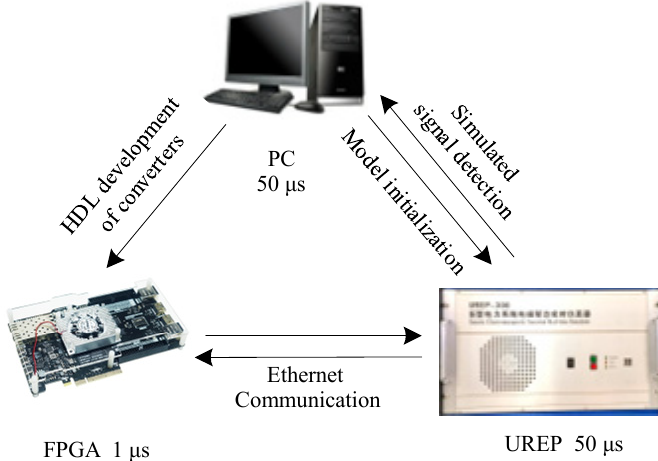
Figure 12. System structure diagram of the experimental platform.